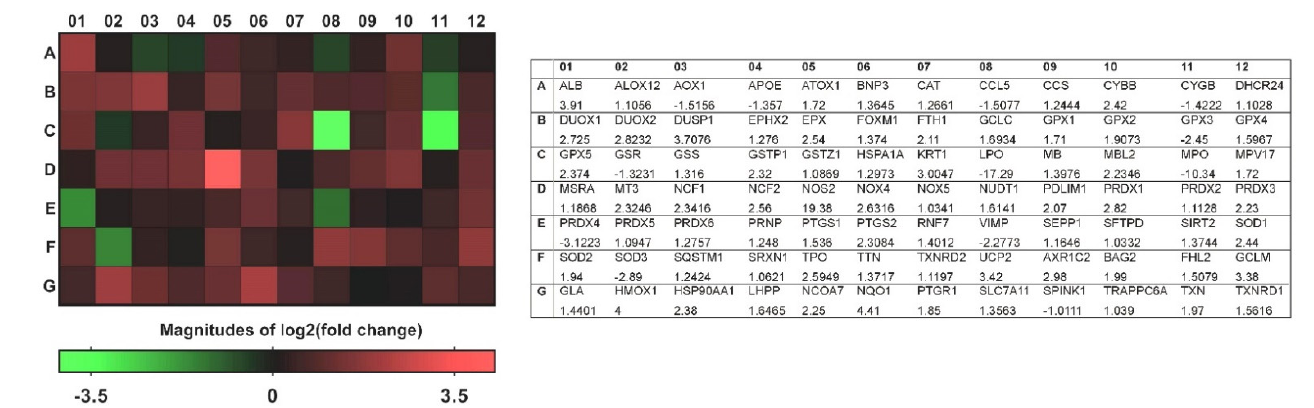
Figure 2. Visualization of fold changes in oxidative stress gene expression between the control and CRSwNP groups for each gene in the array in the context of an array layout. The heat map and table provide fold regulation data used for the map as well as abbreviations for the genes associated with each datum.